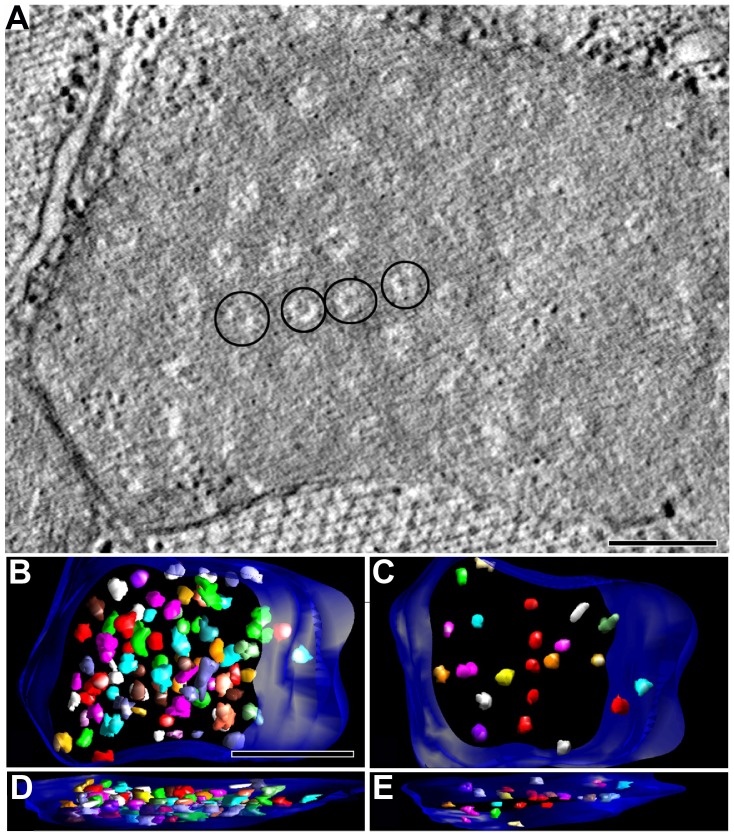
Honeycomb-like structures in the mitochondria of HA flies.(A) Slice through another tomographic reconstruction of a hypoxic mitochondrion in thoracic muscle oriented in cross-section (transverse) to the myofibrils. A honeycomb-like pattern of light, roughly circular regions with a dense center (4 circled) was found. Scale  = 200 nm. (B–E) The segmented honeycomb-like pattern (various colors) shows the spatial distribution and 3D extent of these structures. The full complement of rod-like structures having a dense core that is also rod-shaped, yet narrower is shown in B (top view) and C (oblique view). This mitochondrial volume contained 84 rods in the honeycomb-like structures. A subset of rods (23 total) is shown in D (top) and E (oblique) to note that these rods do not extend completely through the volume (height) of the mitochondrion. Scale  = 500 nm.